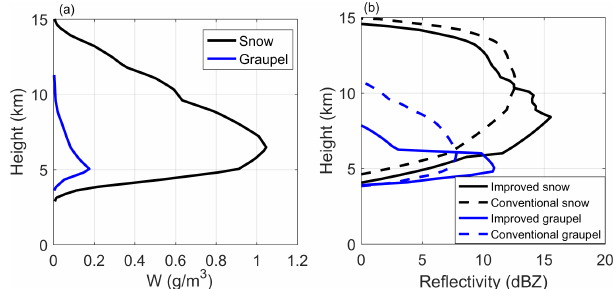
Figure 14. (a) Vertical profiles of water content for snow and grau- pel along the black line in Fig. 12a, where the black line denotes snow, and the blue line denotes graupel. (b) Corresponding reflec- tivity profiles with the improved simulation and conventional sim- ulation, where solid lines denote the simulation result with the im- proved setting, and dashed lines denote the simulation result with the conventional